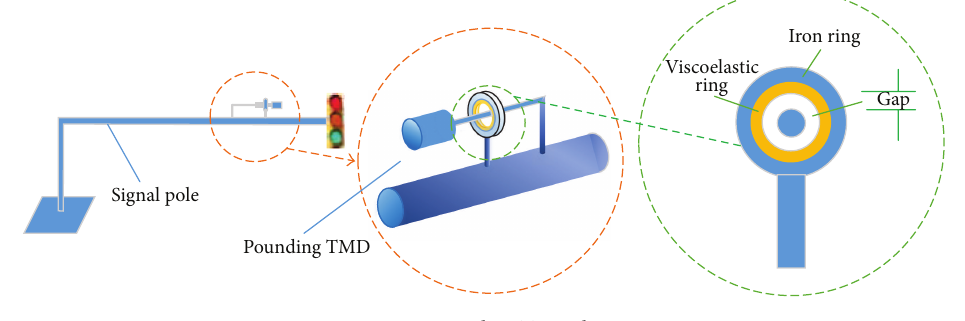
Figure 11: Pounding TMD